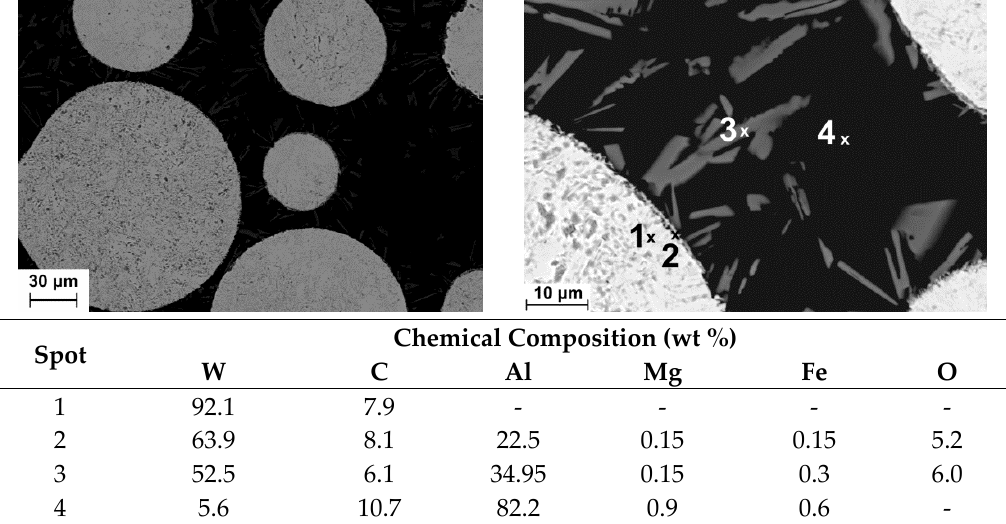
Figure 8. SEM photographs of the Al6061 + WC MMC layer fabricated under conditions the same as in Figure 4, and chemical composition obtained at selected spots.